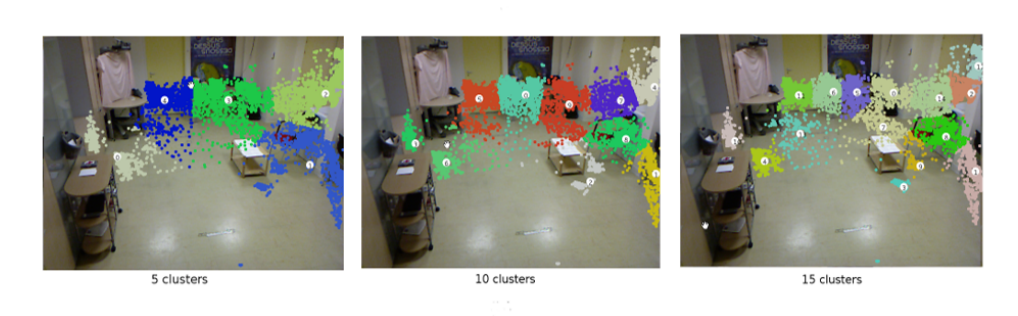
Figure 2. Example of K-means clustering using city-block distance measurements of Centre Hospitalier Universitaire de Nice (CHU) dataset. The number of clusters is set to 5, 10, and